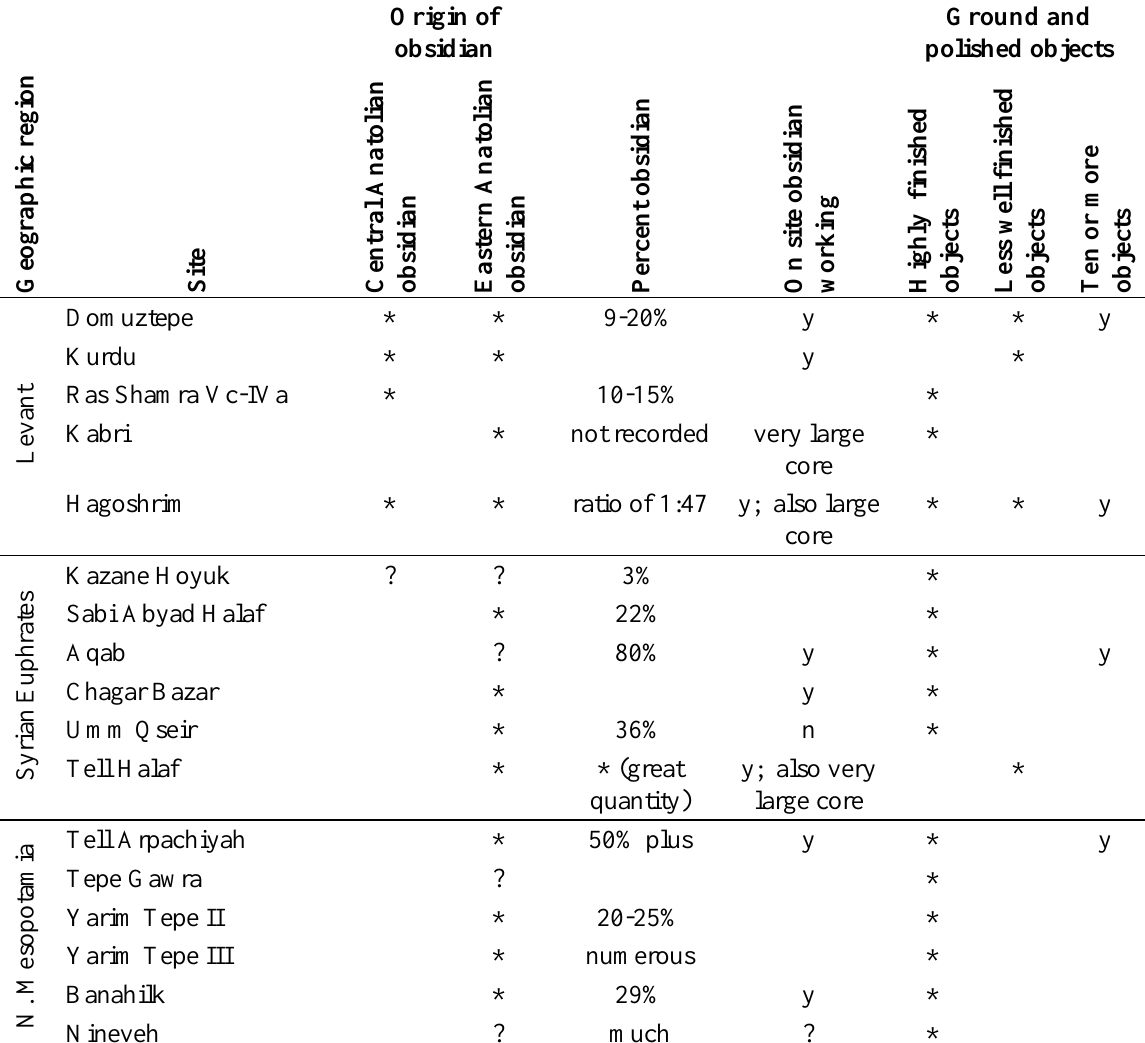
Table 1. The occurrence of ground and polished obsidian at selected sites within the Halaf area of influence broadly contemporary with Late Halaf levels at Domuztepe and Arpachiyah (note there is considerable variation in the amount of information available). For further details see Healey 2007, Table